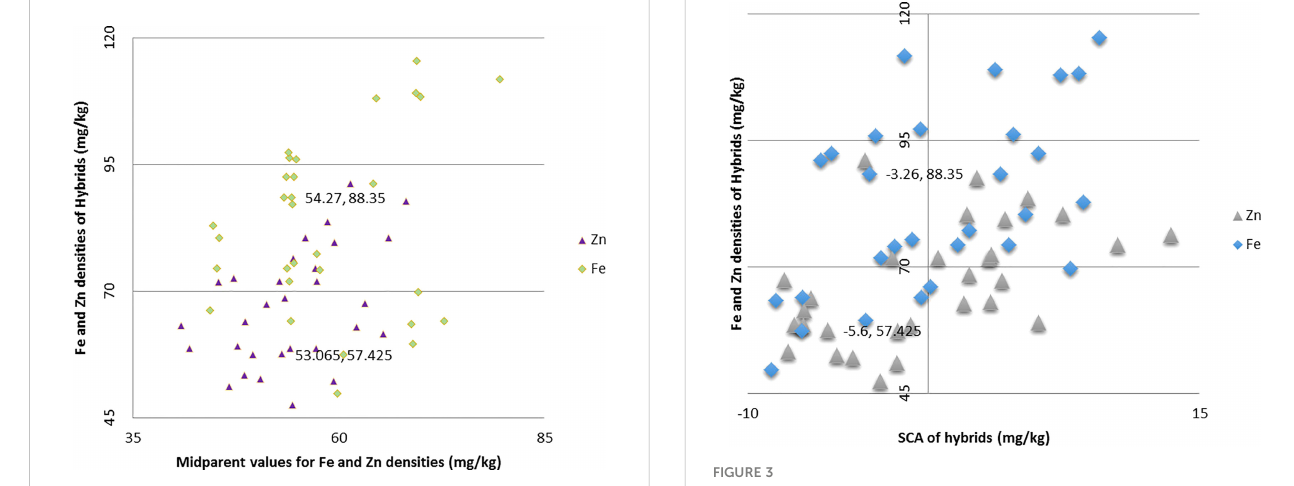
FIGURE 2 Relationship between grain Fe and Zn densities of hybrids and mid- parent values in line × tester trials across two environments.